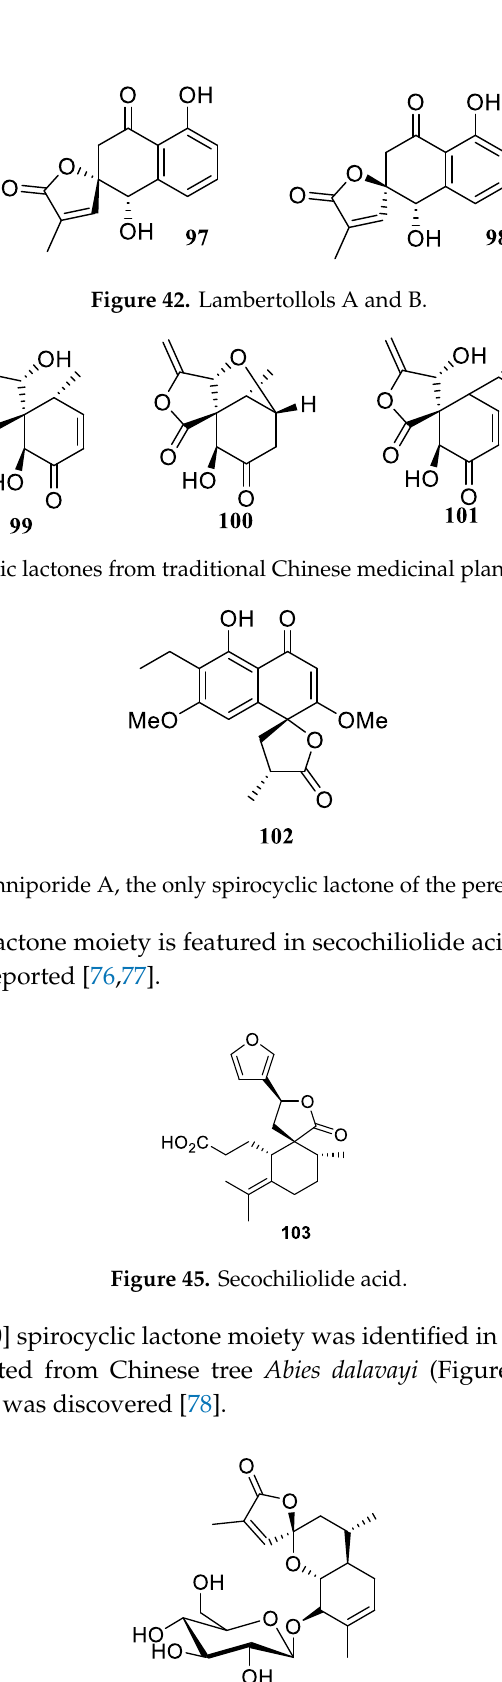
Figure 46. Abiespiroside A isolated from Chinese tree Abies dalavayi .